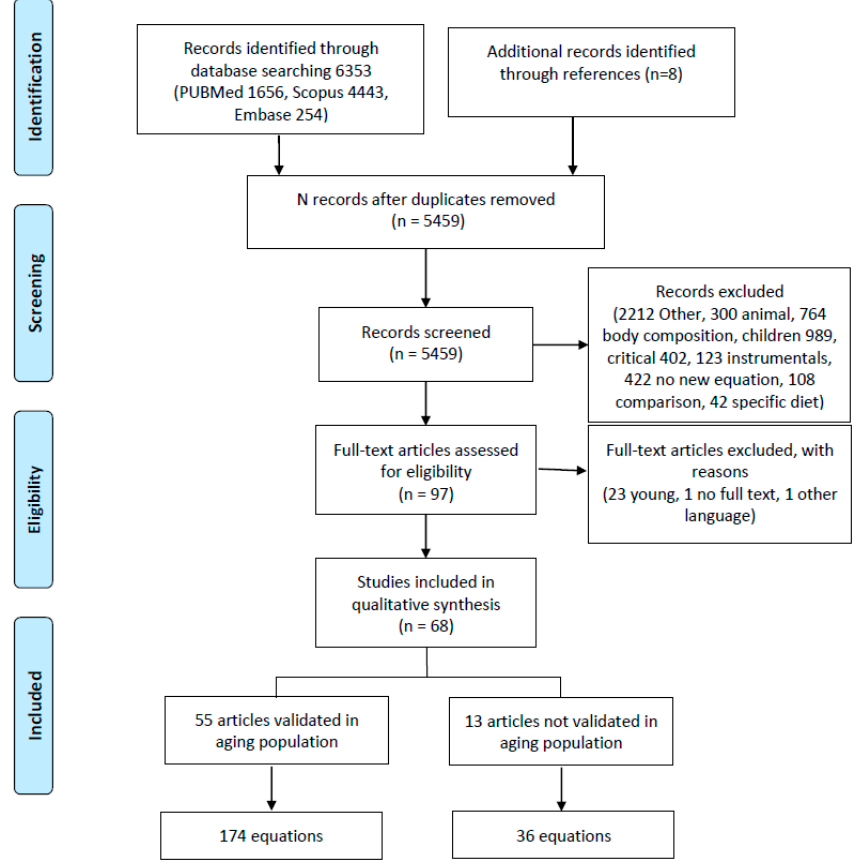
Figure 1. Flowchart of literature search. This figure was based on the PRISMA example.